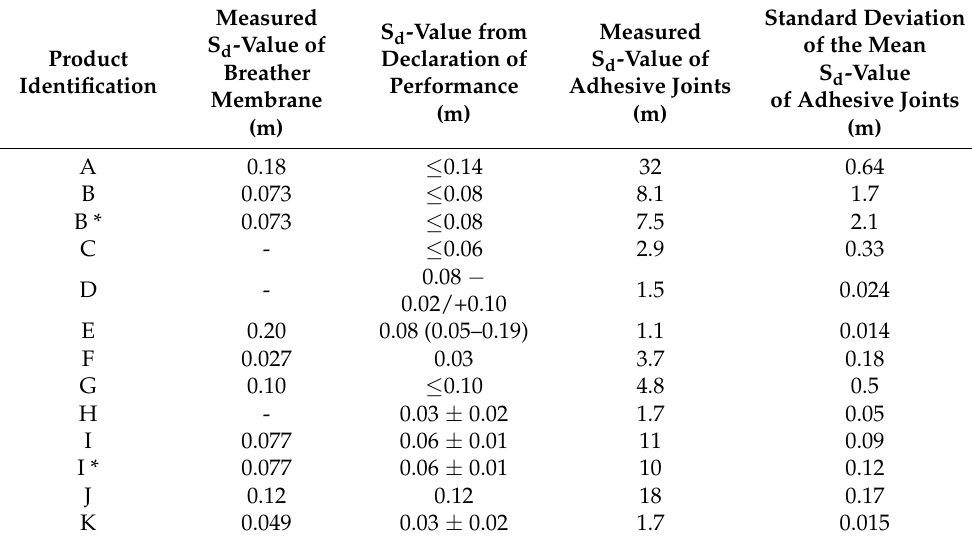
Table 5. Results From Laboratory Measurements Compared to Declared and Measured Water Vapour Resistance of Breather Membranes. Measured S d -Value of Breather Membranes Are Col- lected From SINTEF Archives. Declarations of Performance Are Gathered From SINTEF Technical Approval or The Product Datasheets. Test Series Marked with an Asterisk (*) are the Results from Preliminary Studies.